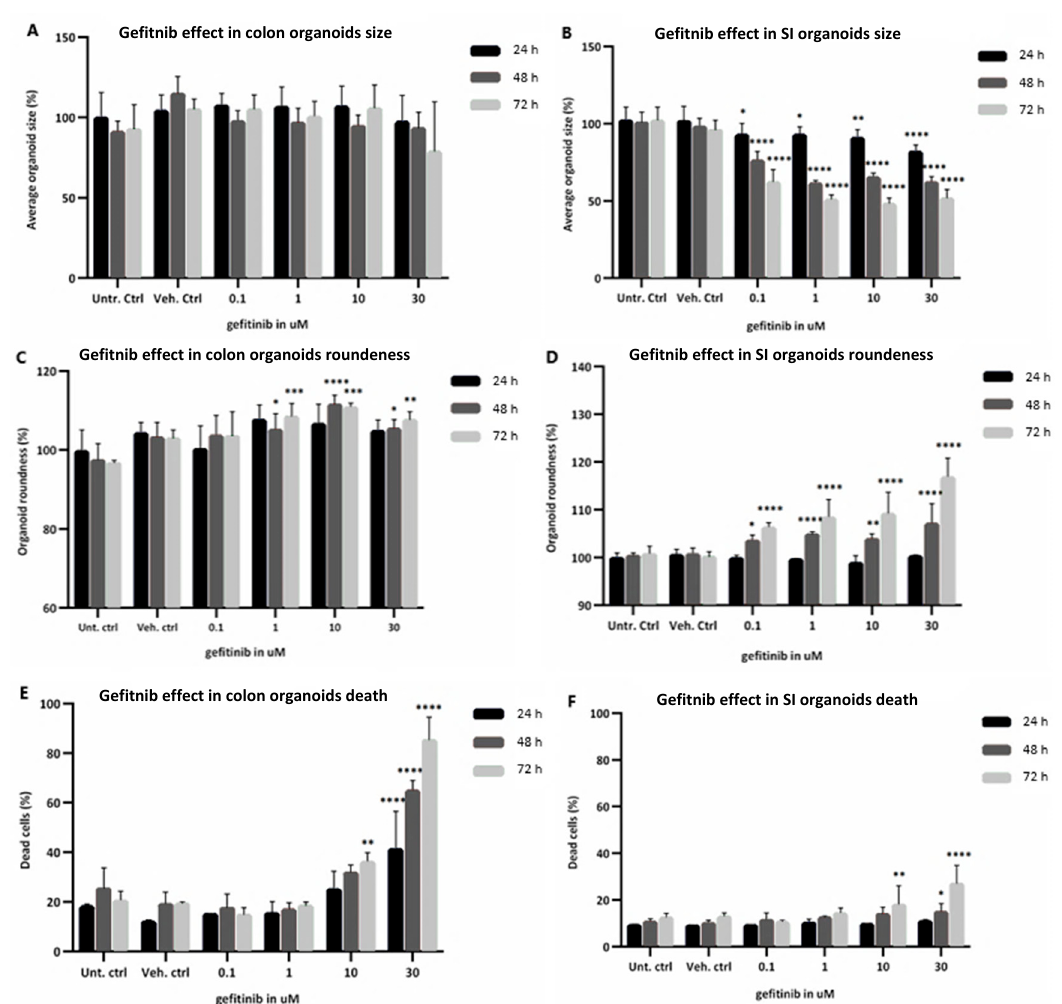
Figure 4. Morphological changes assessed through imaging analysis of healthy colon ( A , C , E ) and SI ( B , D , F ) organoids when exposed to 0.1, 1, 10 and 30 µM gefitinib for 24 h in black, 48 h in light grey and 72 h in dark grey, compared with untreated controls. ( A , B ): organoid size; ( C , D ): organoid roundness; ( E , F ): percentage of dead cells. Values are in % based on fluorescent intensity for each measured parameter. SD was calculated for each condition. Legend: Ctrl, control; SD, standard deviation; SI, small intestine; Unt, untreated; Veh, vehicle. * p -value = 0.01; ** p -value = 0.008; *** p -value = 0.0008; **** p -value = 0.0001.